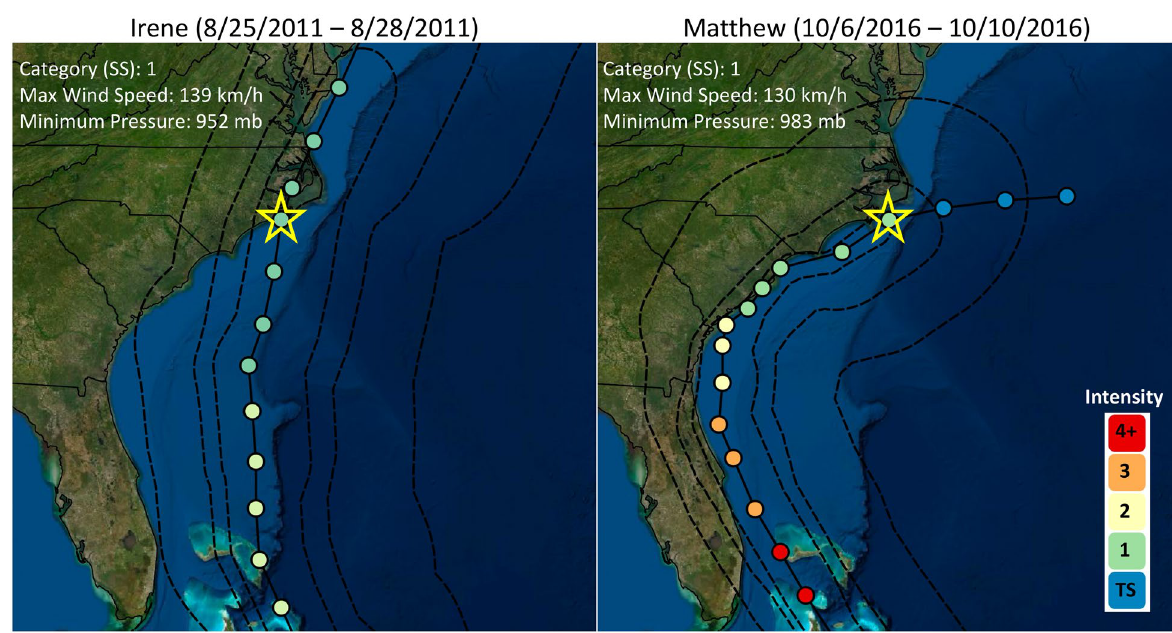
Figure 3. Best track and wind field indicated for hurricanes Irene and Matthew. Wind speed and pressure characteristics recorded for position nearest landfall in North Carolina (indicated by star). Intensity presented based on Saffir-Simpson (SS) scale. Best track information available via the National Hurricane Center, https:// www. nhc. noaa. gov/ gis/. Figure created in QGIS (Version 3.16, https:// qgis. org/ en/ site/ forus ers/ downl oad. html) using ESRI Satellite imagery as